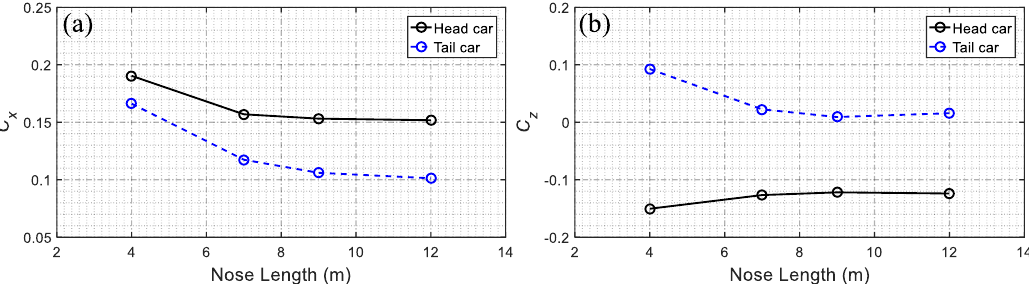
Figure 8. Time-averaged aerodynamic ( a ) drag coefficients, and ( b ) lift force coefficients of the head and tail cars.